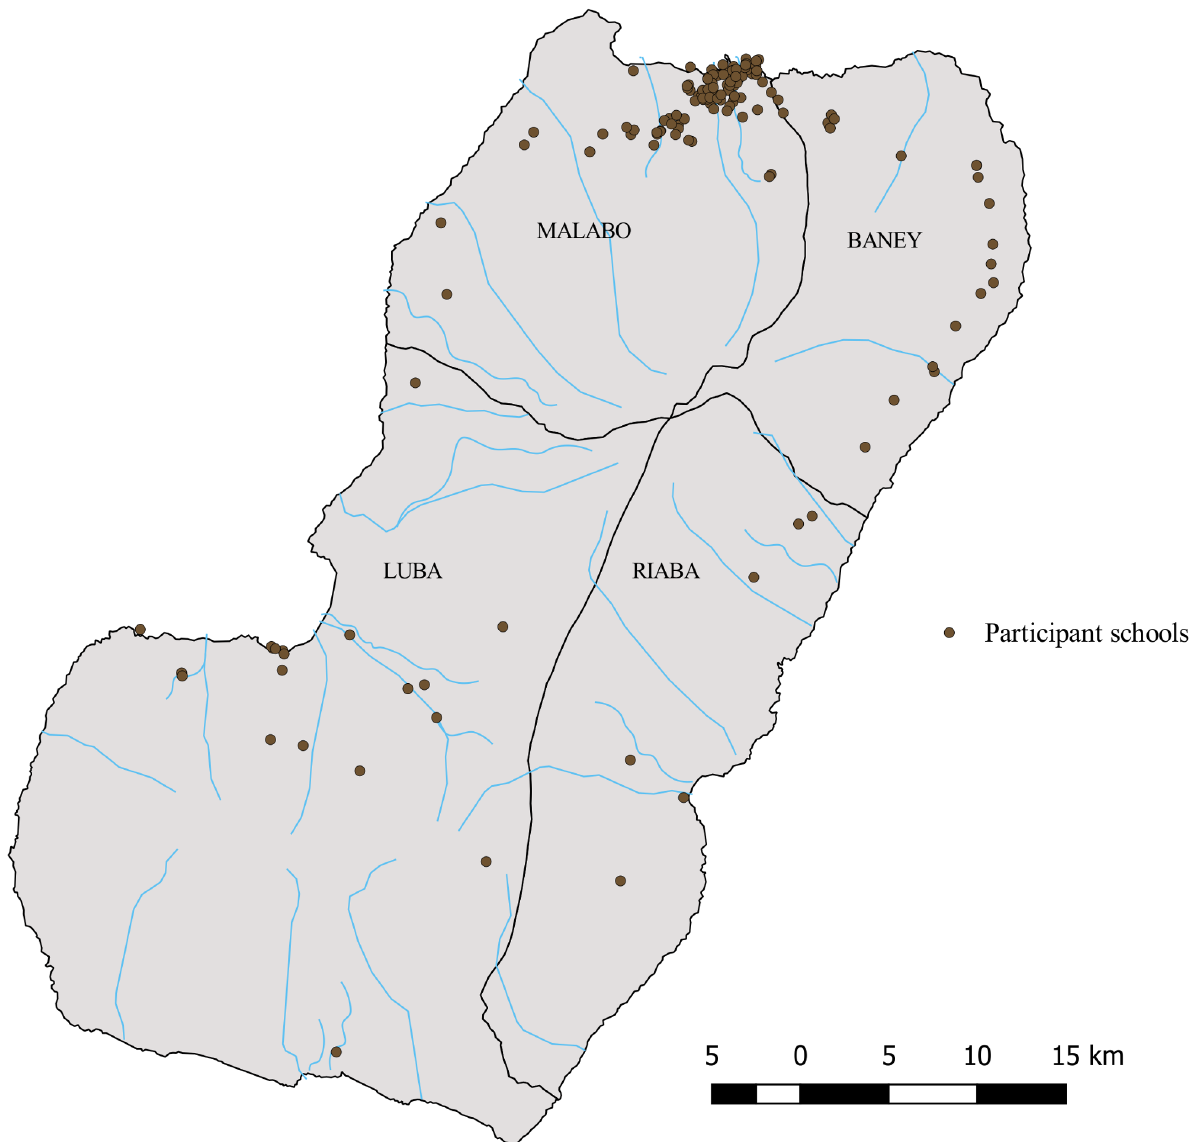
Fig 1. Geographical distribution of participant schools in Bioko Island, September 2016 to January